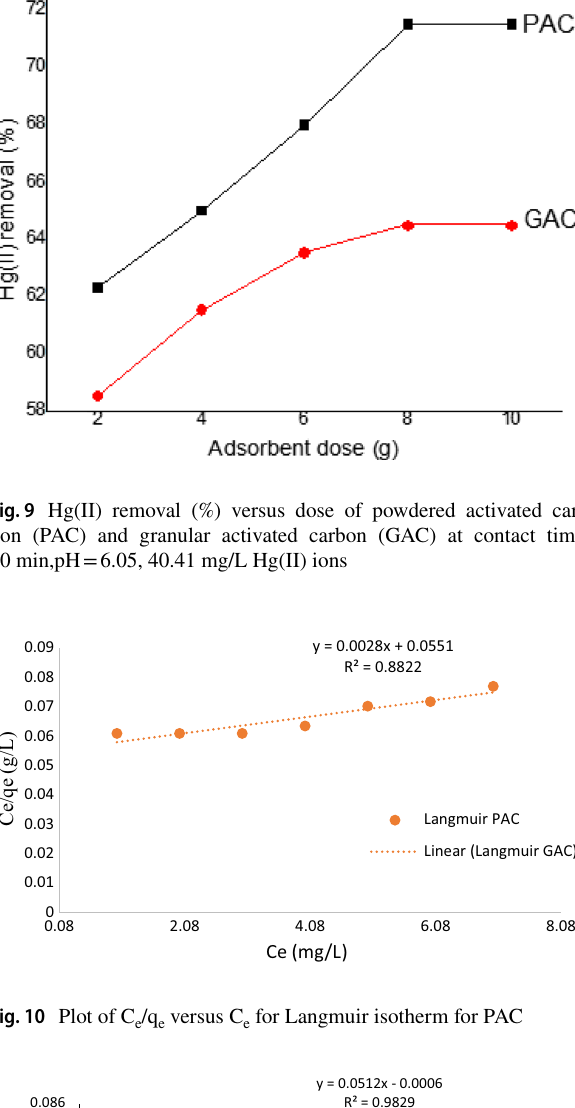
Table 5 linear fit analysis derived from Fig. 3 for PAC and GAC